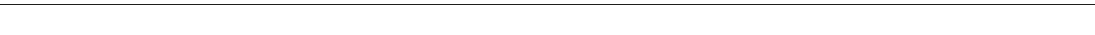
Fig. 8 Rg CBM40 binding to mucus-producing cells and intestinal tissue sections. a Immunostaining pattern for Rg CBM40 on LS174T cells correlated with mucin (MUC2) and lectin (SNA) staining, all shown in green. No staining was observed in Rg CBM40-free sample (Blank). b Immunostaining pattern for Rg CBM40 on cryosections of mouse colon correlated with mucin (Muc2) and lectin (SNA) staining, all shown in green. No staining was observed in Rg CBM40-free sample (Blank). Cell nuclei were counterstained with DAPI, shown in blue. c Sialidase pre-treatment of mouse colonic cryosections markedly reduced the binding of Rg CBM40 and SNA lectin. Cell nuclei were counterstained with DAPI, shown in blue. d Rg CBM40 competition assay with SNA on cryosections of mouse colon. Rg CBM40 is shown in green. Cell nuclei were counterstained with DAPI, shown in blue. No Rg CBM40 speci fi c staining was detectable when SNA was present. e R. gnavus binding competition assay with SNA on cryosections of mouse colon. R. gnavus ATCC 29149 was incubated on sequential cryosections of mouse colon with or without SNA treatment and is shown in red. The mucus layer is shown in green. Sequential sections were required as both antibodies were raised in the same species. Cell nuclei were counterstained with DAPI, shown in blue. No R. gnavus staining was detectable when SNA was present. Appropriate primary antibody and secondary antibody only controls are also shown underneath each panel, showing some background staining. Scale bar: 20 μ